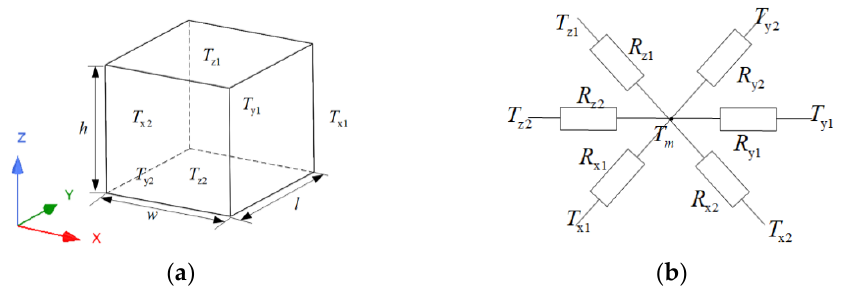
Figure 4. Cuboid heat conduction model: ( a ) Cuboid structure; ( b ) Equivalent thermal network model.